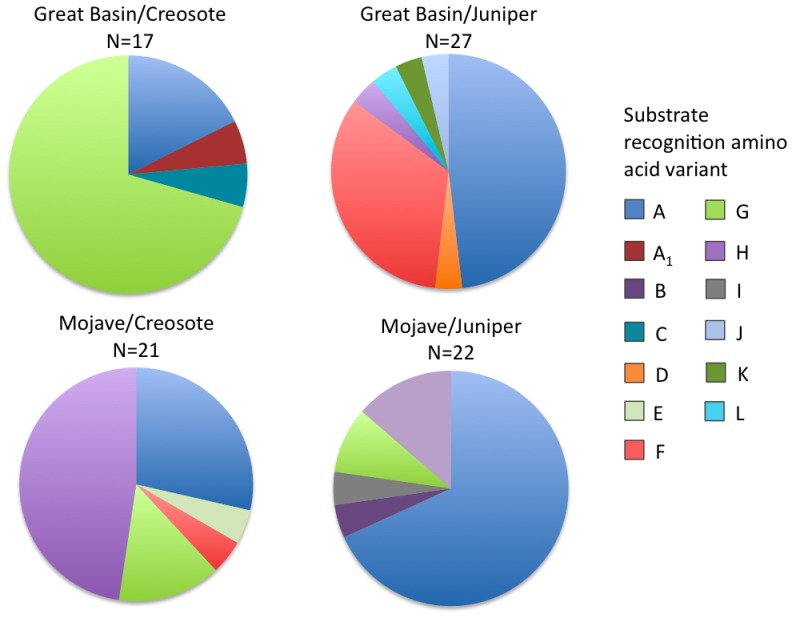
Differential distribution of sequenced CYP2B clones across population by dietary treatment.Colors represent groups of sequences with unique combinations of 13 substrate recognition amino acid residues important for CYP2B enzyme function. The smallest wedges in each pie are a unique combination of substrate recognition amino acids that occurs only one time in that treatment. Letters correspond to amino acid characterization in Table 3 and phylogenetic relationships described in Figure 3.